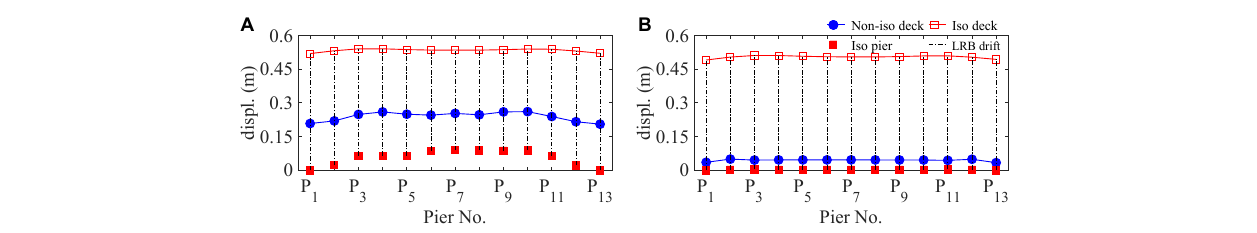
FIGURE 10 | The mean value of the maximum resultant displacement responses under the NF record pairs at piers P 1 to P 13 (A) long-pier models; (B) short-pier models.